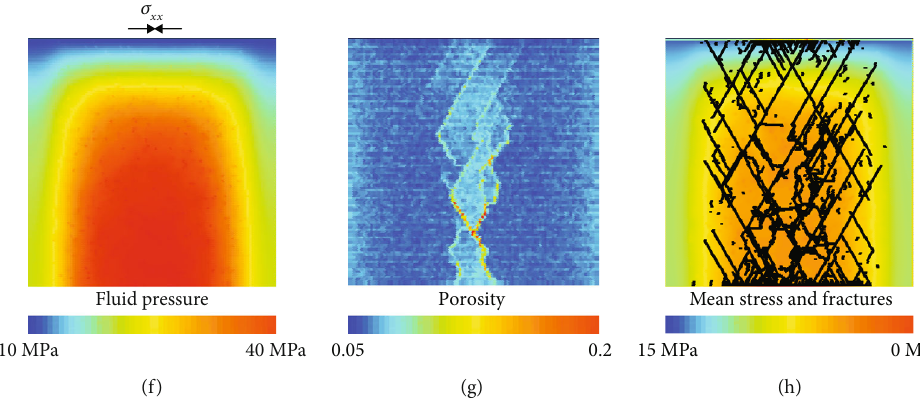
Figure 3: Two end-member cases for the development of e ff ective stresses: fl uid overpressure zone versus fl uidization. (a) The e ff ective stresses for scenario 1 where all stresses including the di ff erential stress decrease and become zero. (b) The fl uid pressure, (c) the porosity pattern, and (d) the mean stress in color and corresponding fractures in black. Scenario 1 leads to a semihorizontal high-porosity channel and a breccia-like fracture zone. (e) The stresses for scenario 2 with the e ff ective mean stress decreasing while the e ff ective di ff erential stress stays almost constant. (f) The fl uid pressure, (g) the porosity pattern, and (h) the mean stress and fractures for the fl uid overpressure zone. A vertical central dilating zone with high-porosity channels develops in a zone that is much narrower than the high fl uid pressure zone and the fracturing. Time is in hours (relative color scale below the fi gure).